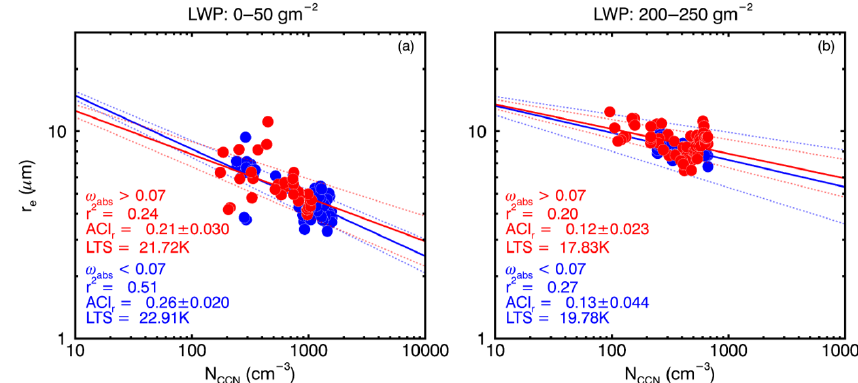
Figure 8. r e as a function of N CCN and the values of ACI r under the strongly absorptive (in red) and the weakly absorptive (in blue) aerosol regimes at two LWP bins: 0–50gm − 2 (a) and 200–250gm − 2 (b) . Note that the dashed lines denote the uncertainties of ACI r due to 10% error in r e